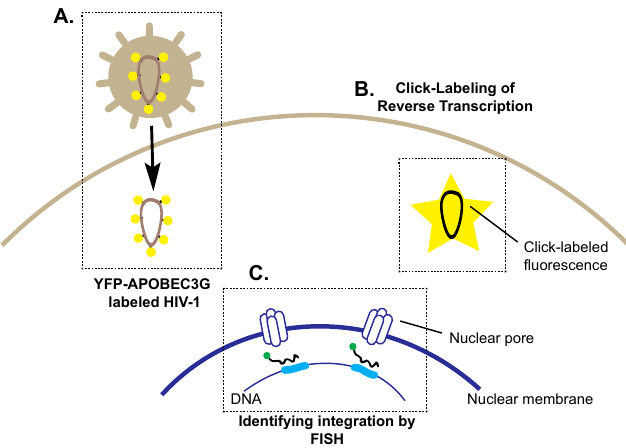
Figure 3. Selected imaging techniques and vectors used to identify key steps in HIV-1 trafficking to the nucleus. ( A ) yellow fluorescent protein-apolipoprotein B mRNA editing enzyme catalytic subunit 3G (YFP-APOBEC3G)-labeled HIV-1 virions (represented by yellow circles) demonstrate the trafficking of the nucleocapsid to the nuclear pore; ( B ) Click-labelling allows detection of reverse transcription in the infected cell, where the incorporation of 5’-ethynyl 2’-deoxyuridine into newly synthesized viral DNA results in detectable fluorescence, represented by the yellow star; ( C ) The use of fluorescence in situ hybridization (FISH) probes ( black with green fluorophore) identified that preferential integration sites ( blue ) are located near nuclear